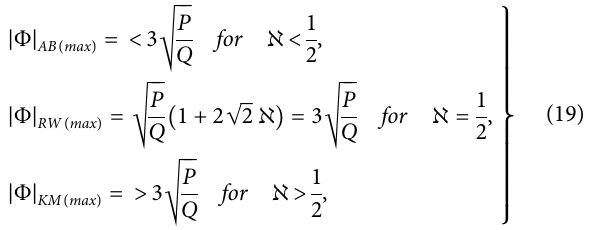
Frontiers in Physics |